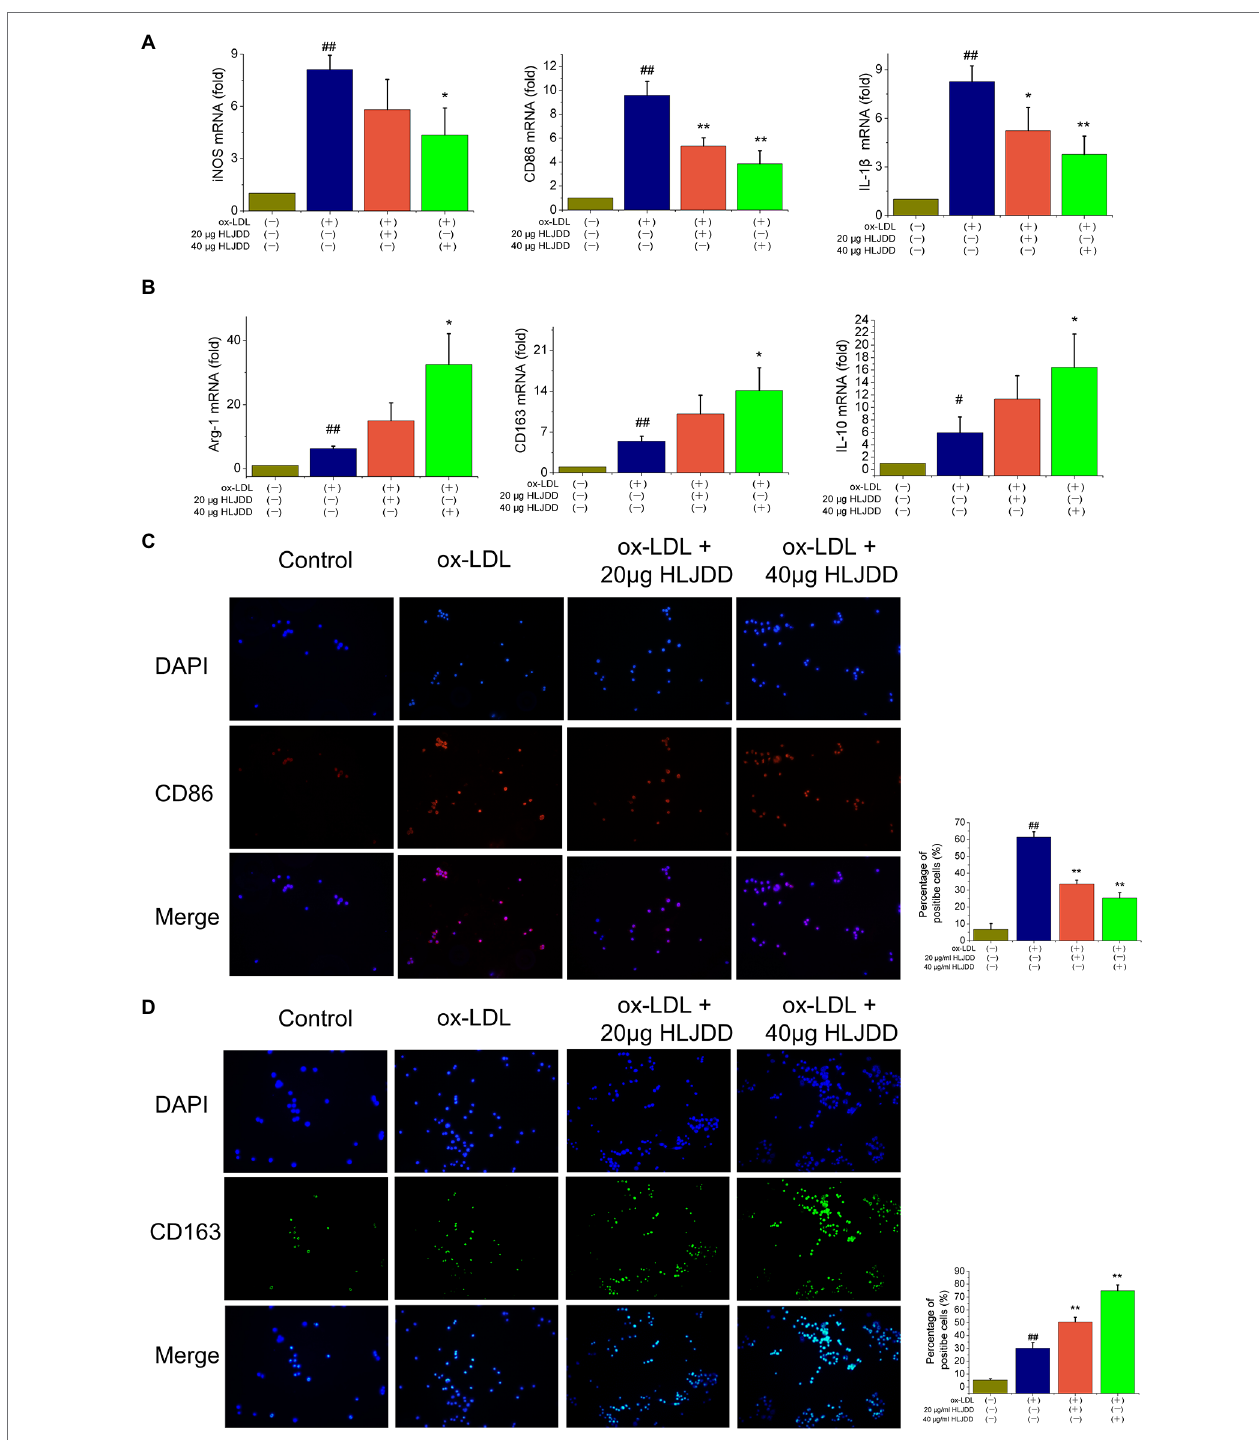
FIGURE 5 | Effects of HLJDD on macrophage polarization in ox-LDL-induced RAW264.7 cells. RAW264.7 cells were pretreated with HLJDD (20 or 40 μ g/ml) for 12 h, and then exposed to ox-LDL for another 24 h. (A) The mRNA level of iNOS, CD86, and IL-1 β were detected by real-time PCR. Values are expressed as the mean ± SD. (B) The mRNA level of Arg-1, CD163, and IL-10 were detected by real-time PCR. Values are expressed as the mean ± SD. (C) Representative immunofluorescence images showing CD86 expression in RAW264.7 cells. The percentage of cells that were positive for CD86 fluorescence were quantified by Image Pro Plus 6.0 software. (D) Representative immunofluorescence images showing CD163 expression in RAW264.7 cells. The percentage of cells that were positive for CD163 fluorescence were quantified by Image Pro Plus 6.0 software. Values are expressed as the mean ± SD from three independent experiments ( ## p < 0.01 vs. the control group; * p < 0.05 and ** p < 0.01 vs. the model group; one-way